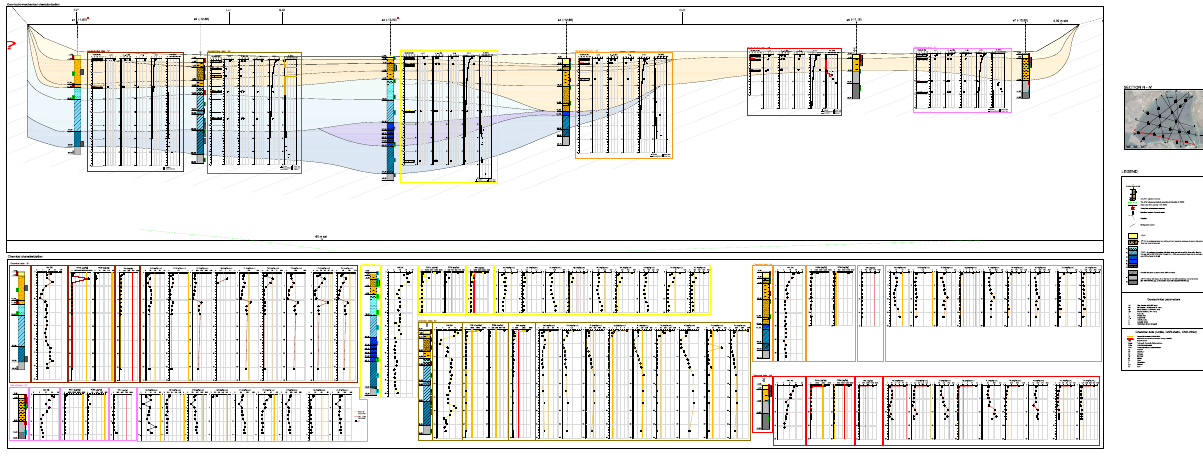
Figure 11. Geo-chemo-mechanical section N–N ′ GCM